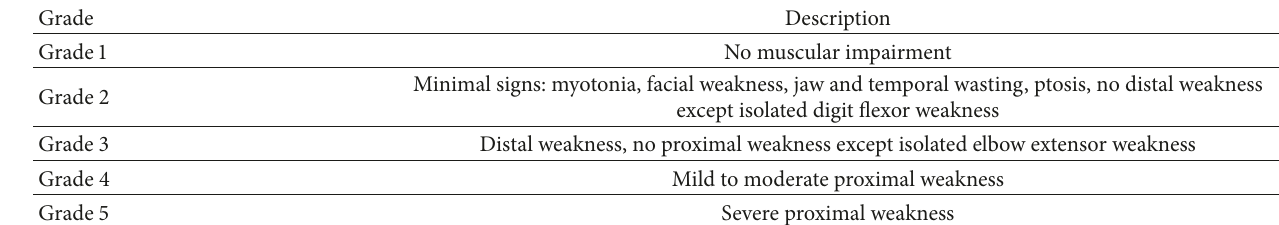
Table 2: Muscular impairment rating scale